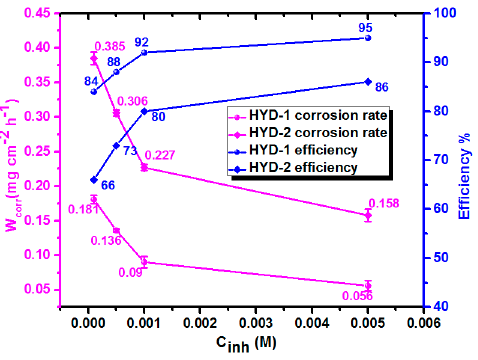
Figure 2. The variation of corrosion rate and protection efficiency with the HYD-1 and HYD-2 concentrations for mild steel in 1.0 M HCl at 303 K.